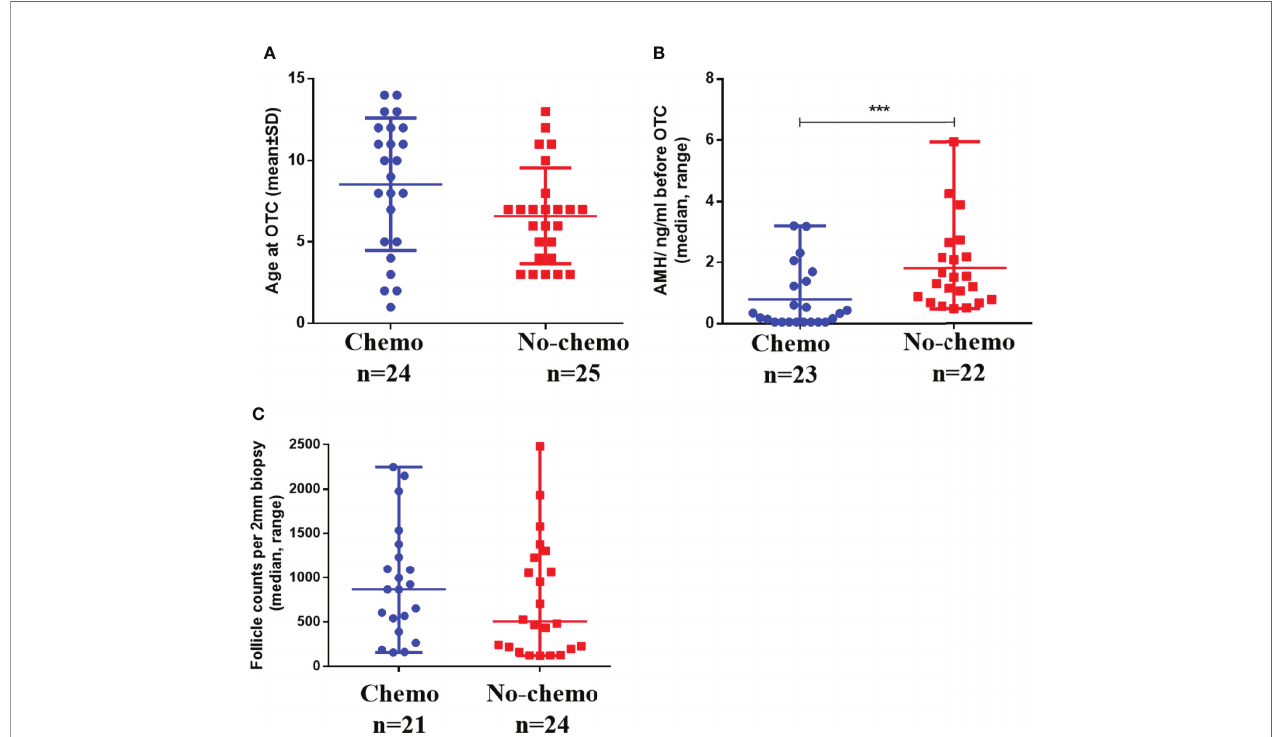
FIGURE 5 | Comparison of age (A) , AMH (B) , and follicle count per 2-mm biopsy (C) in children with and without chemotherapy before OTC. *** refers to P<0.001. OTC, ovarian tissue